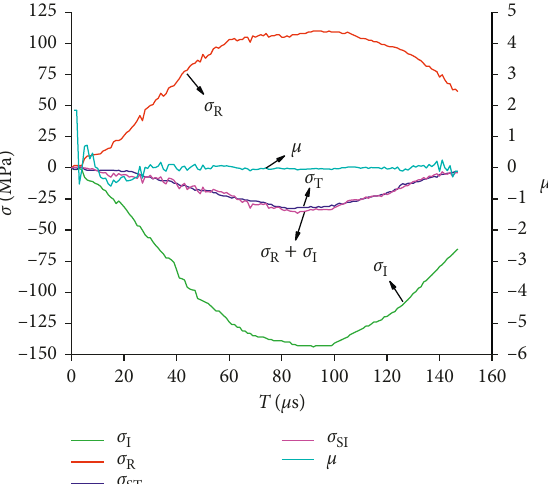
Figure 11: Balance factor for specimens under static-dynamic loads.